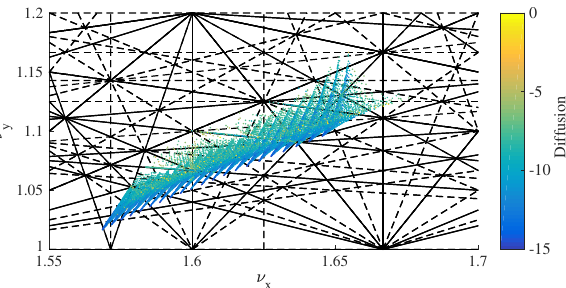
FIG. 7. Tune footprint for off momentum particles.